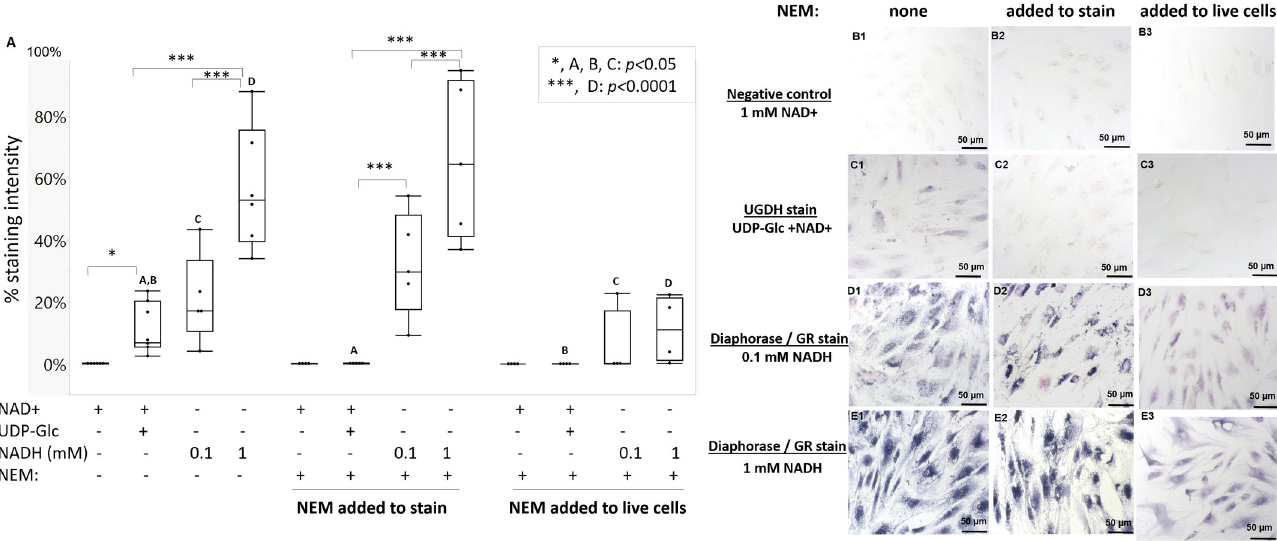
Fig 3. NEM abolished UGDH enzyme histostaining but only partly inhibited diaphorase staining when added to live cell cultures. (A) Quantitative histomorphometry of staining intensity for FLS stained for NAD+ only, UGDH, or diaphorase/GR, with and without NEM. NEM was either included in the staining solution (“in stain”) or added to cell cultures at 1 mM NEM for 2 hours before enzyme staining (“added to live cells”). Representative images of histostained FLS from one female donor, showed no stain for (B1-B3) the negative control (NAD+ only), NEM-sensitive staining for (C1-C3) UGDH (UDP-Glc and NAD+), and NEM-resistant staining for (D1-D3) “low diaphorase/GR”, (E1-E3) “high diaphorase/GR stain”; (B1-E1) no NEM, (B2-E2) NEM “added to stain”, or (B3-E3) NEM “added to live cells”. In panel A, significant differences are noted with letters and symbols ( � , ��� ). The graph in Panel (A) shows the median, 25% quartile range (box), min-max, distinct cultures with 2 female human donors and 1 male donor FLS (n = 4–7). Scale bars: 50 μ m.